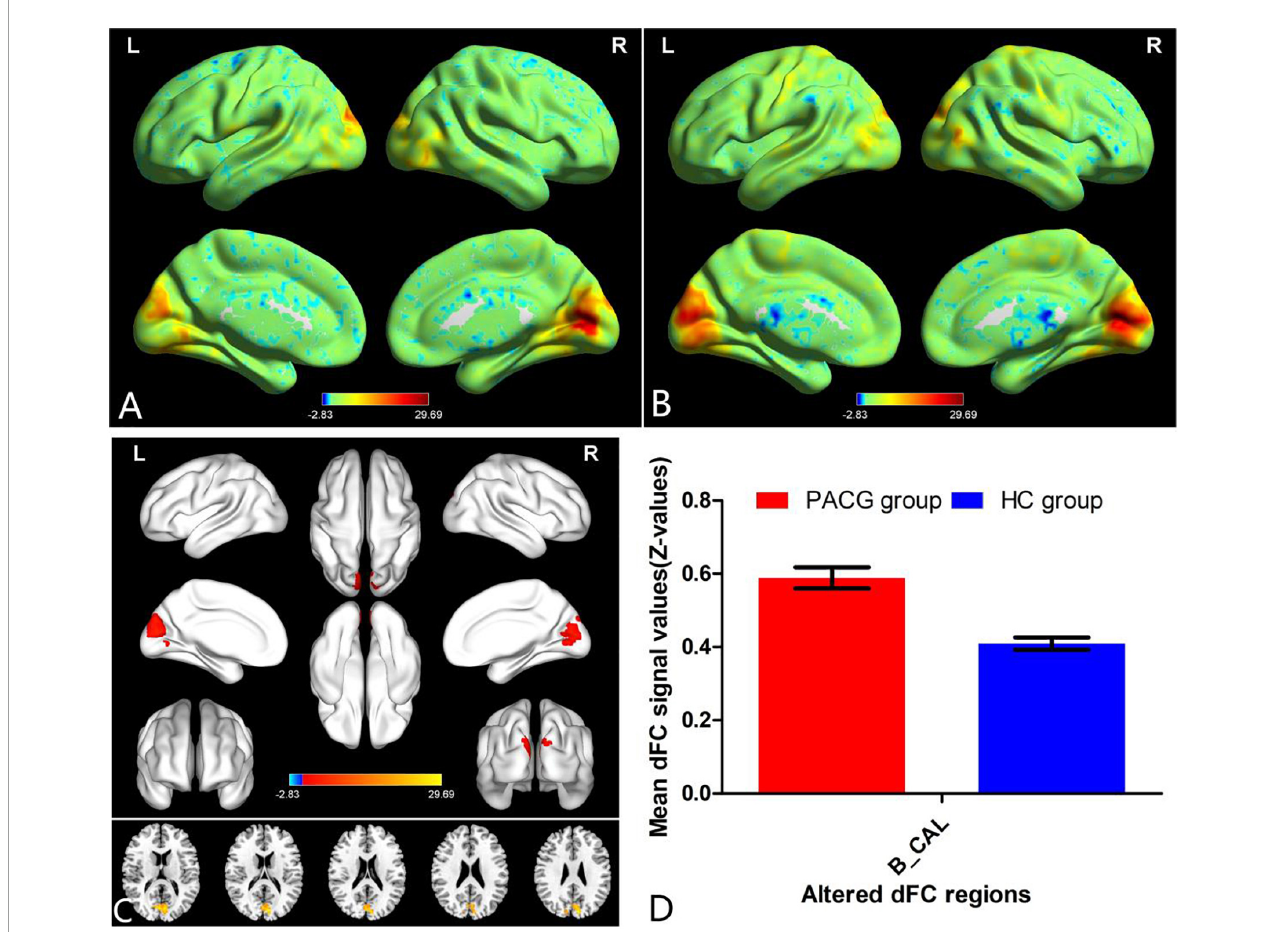
FIGURE2 One-sample t -test results of dFC in right V1 maps within PACG group (A) and HC group (B) ; significant dFC differences in right V1 between two groups (C) ; the mean of altered dFC values of right V1 between the patients with PACG and HCs (D) . PACG, primary angle-closure glaucoma; HC, health control; V1, primary visual cortex; dFC, dynamic functional connectivity; CAL, calcarine; B, bilateral; R, right; L, left.